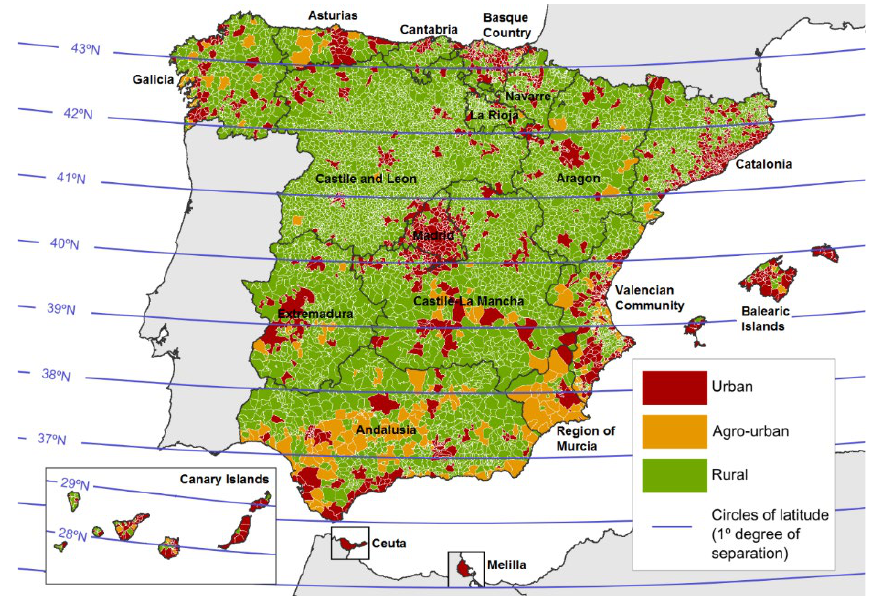
Figure 3. Classification of urban, agro-urban and rural municipalities in Spain. Latitude bands are shown.